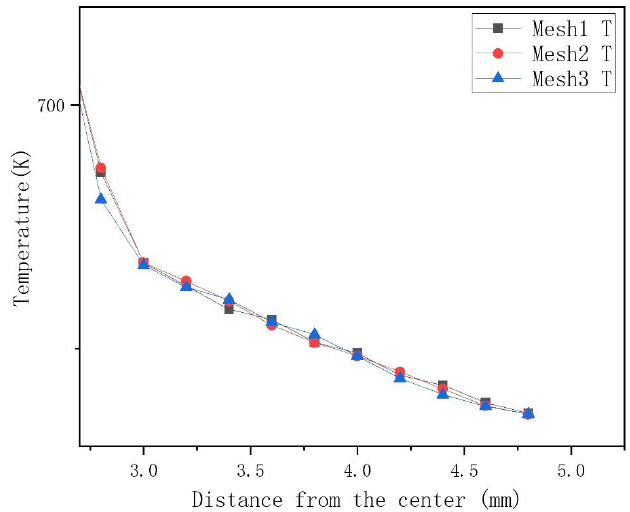
Figure 15. Radial temperature profiles for different mesh